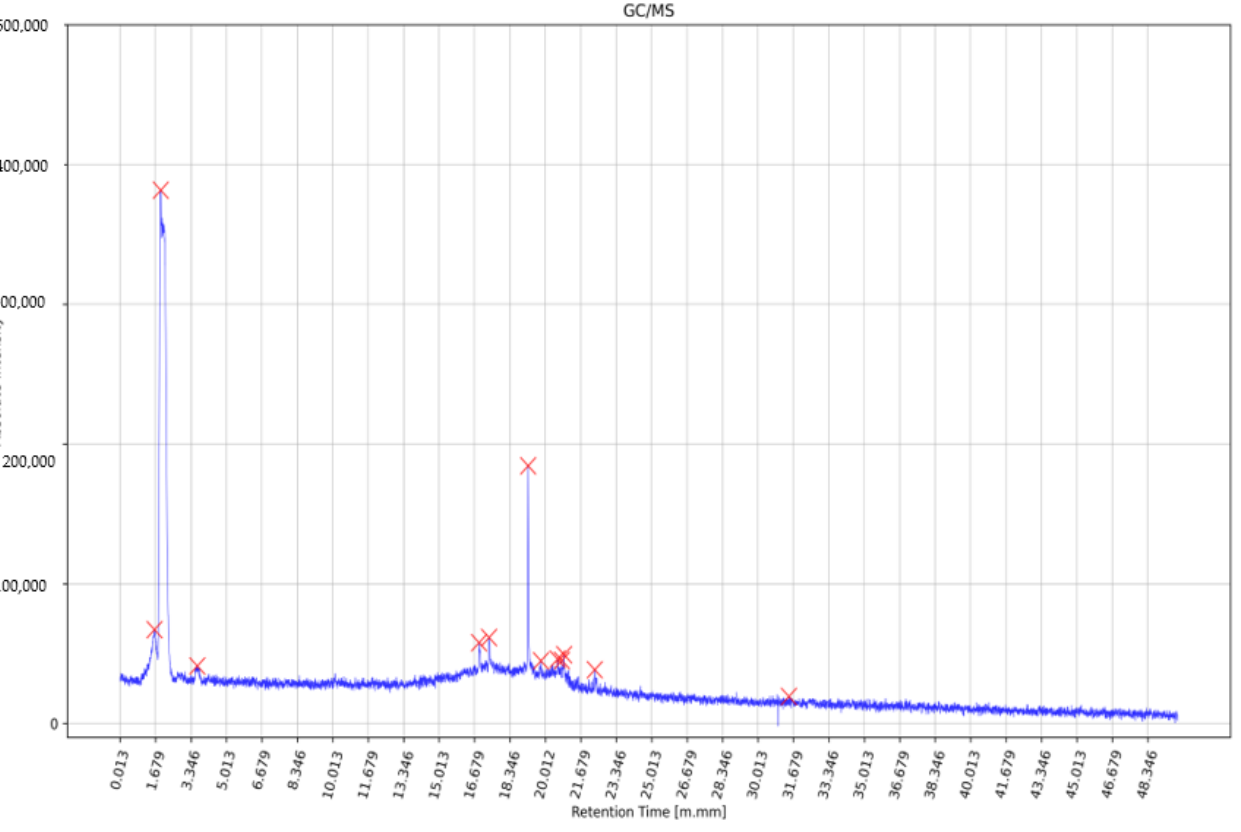
Figure 1. Example of the single patient data with detected peaks (depicted as red crosses).